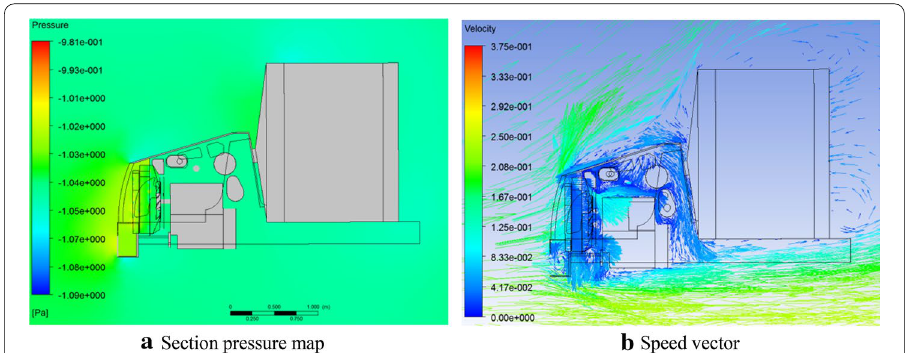
Fig. 3 Section pressure and speed diagram at idle ( x